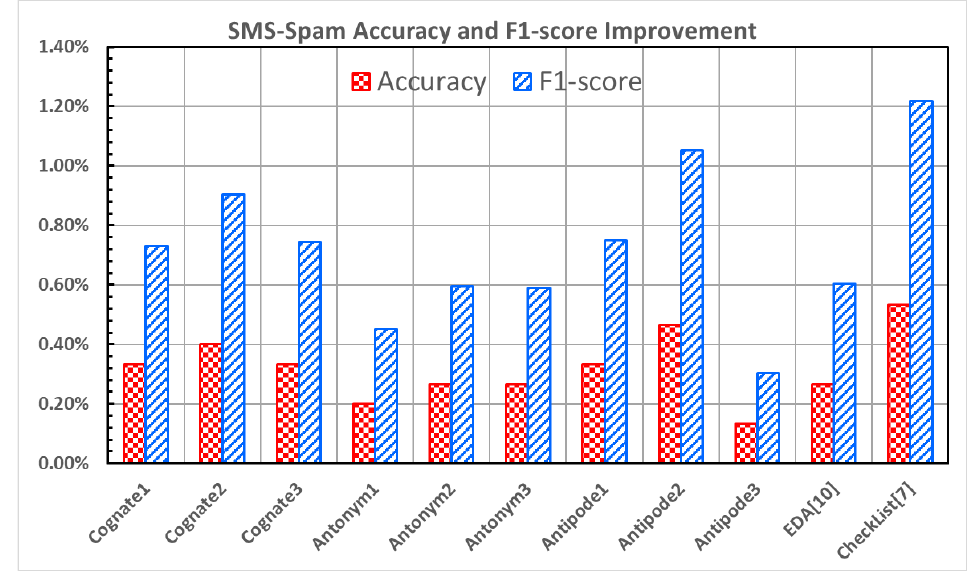
Figure 4. SMS-Spam Performance Improvement Results.